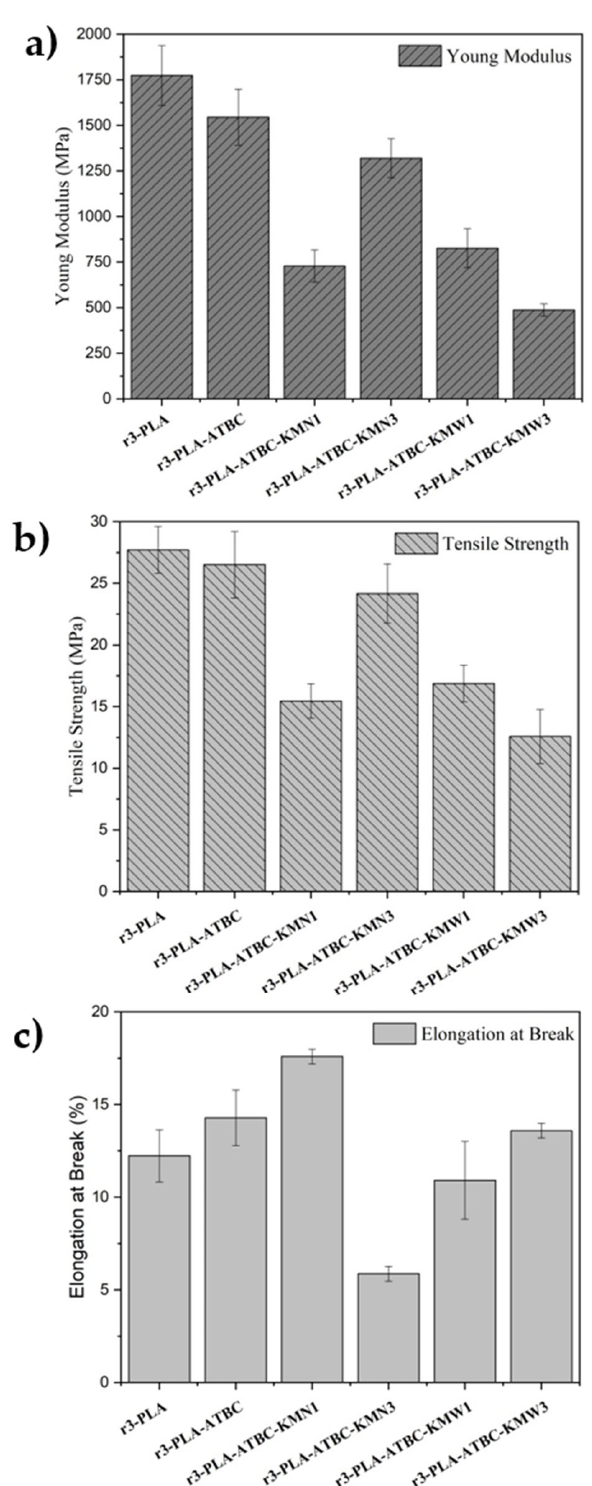
Figure 6. Tensile test measurements of 3r-PLA-ATBC-based films: ( a ) Young modulus, ( b ) Tensile Strength and ( c ) Elongation at break.